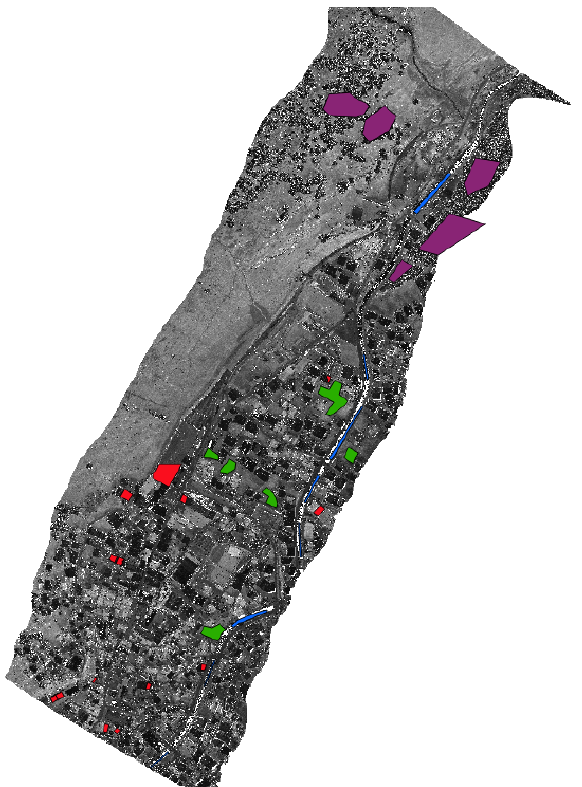
Figure 8: Overview of the areas of interest in the comparison of lidar and HSI datasets recorded over the town of Zermatt. The ALS-derived diffuse reflectance in the wavelength of 1550 nm is shown in the background. The test areas are shown as red (roof tops), blue (rivers), green (meadows) and purple polygons (high vegetationin forests) .